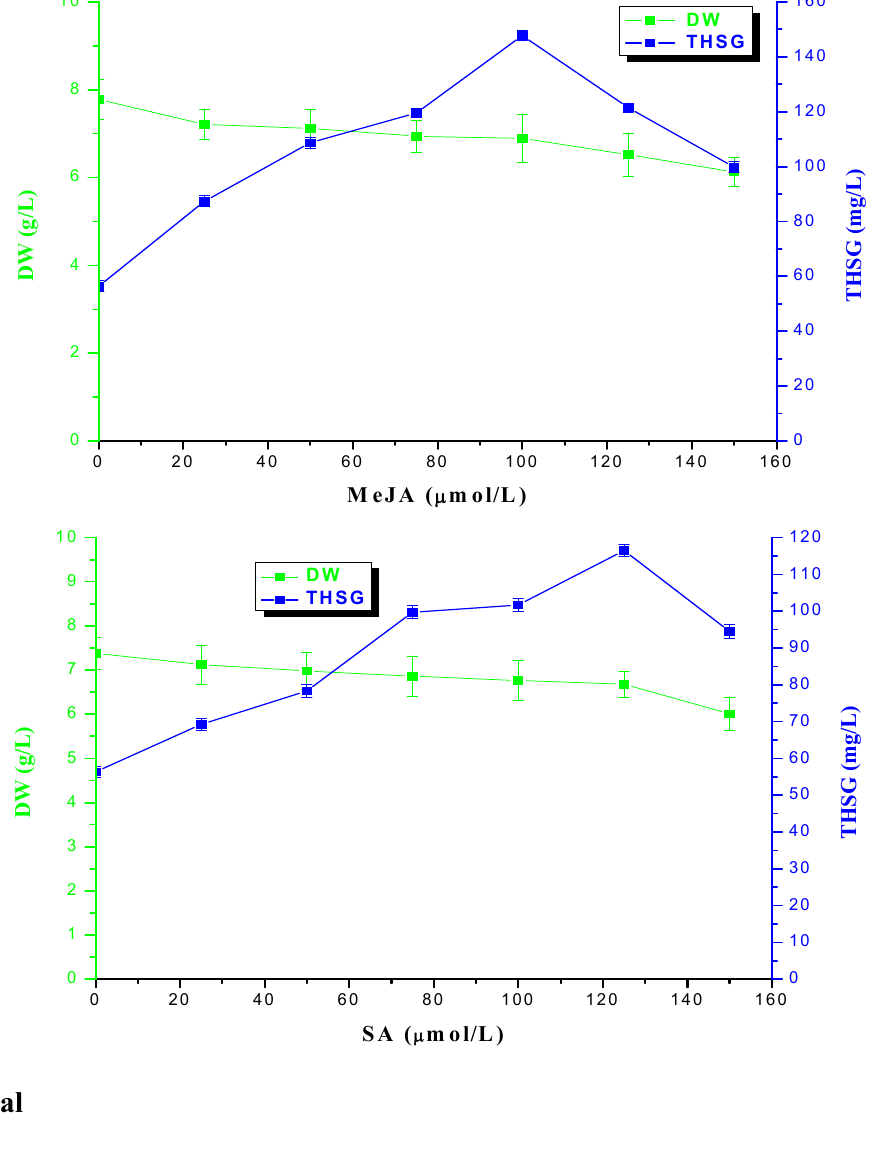
Figure 5. Effect of MeJA (upper) and SA (lower) concentration on DW production and THSG accumulation in MS medium. FW cells were inoculated into MS medium in a 250 mL shake flask on a rotary shaker (100 rpm) in the dark and at 25 °C. The vertical bar represents the standard error of three replicate. Elicitors were added on the 10th day of